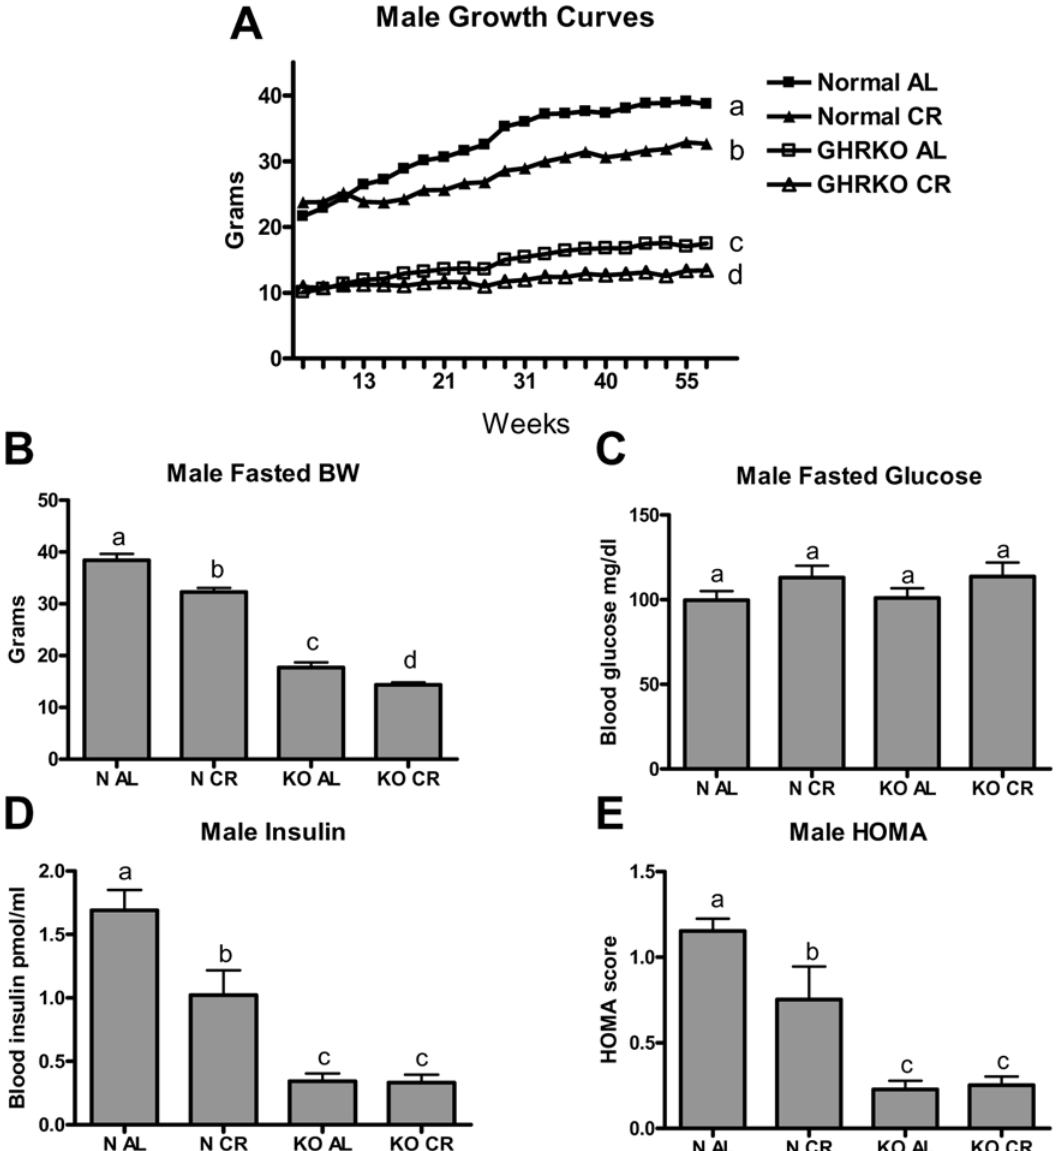
Figure 1. Metabolic parameters of male GHRKO (KO) and normal (N) mice fed adlibitum (AL) or subjected to 30% calorie restriction (CR) for one year. Panel (A) shows time-course changes in body weight over a one year period. After one year of CR, all groups were fasted overnight and bodyweight (B), peripheral glucose (C), insulin (D), and calculated homeostatic model of assessment (HOMA, E) were determined. Values with unlike superscripts/letters are significantly different (P ,